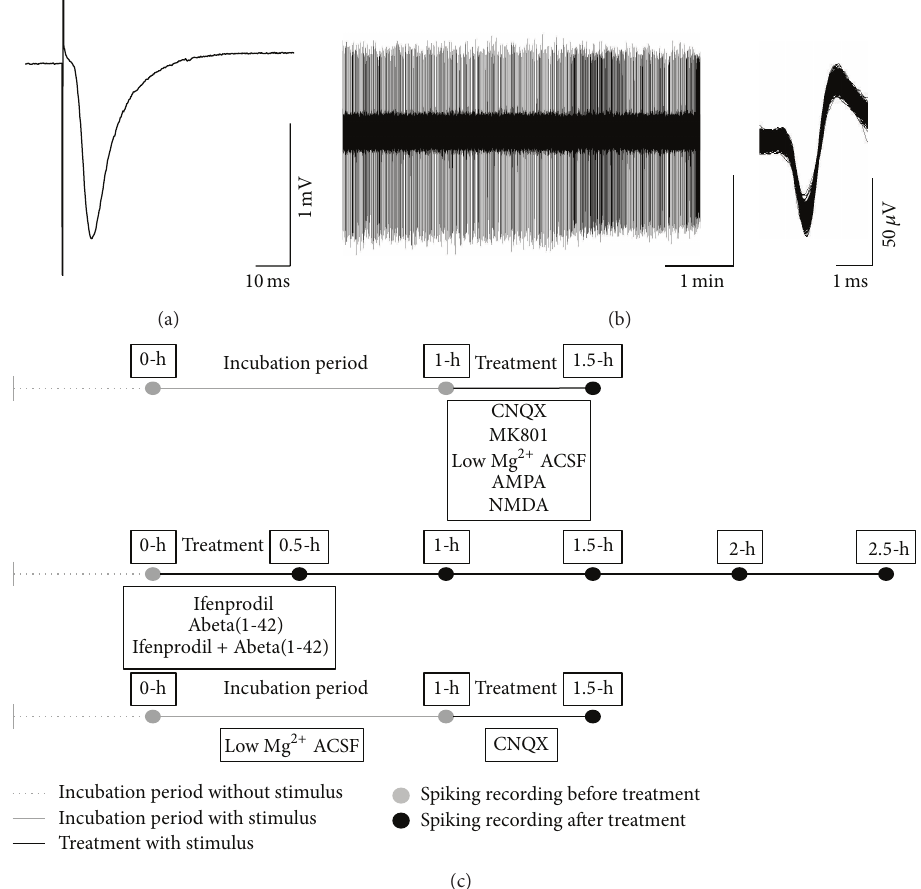
Figure 1: Exemplar recordings and the timeline of the experiments. Both evoked fEPSPs and spiking activity recording electrodes were located in the CA1 region of mouse hippocampal slice. The fEPSPs were recorded from the stratum radiatum (a) and the spontaneous spiking was recorded from the stratum pyramidale (b). Both fEPSPs and spiking activity were recorded from the same slice. Data were considered as multiunit activity. (c) shows the timeline of the recordings. The initial spiking activity (recorded at 0 h) was considered as 100% in each